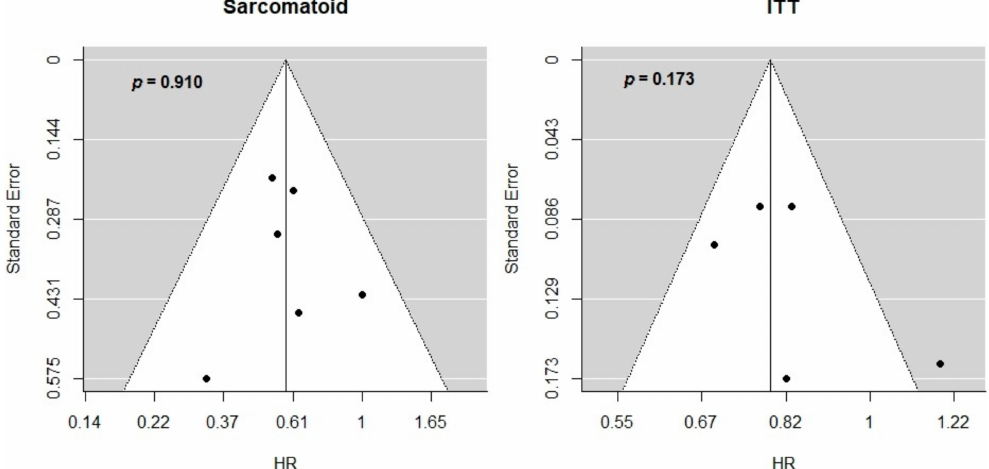
Figure 2. Interactions between HR for progression or death and sarcomatoid histology. Funnel plots of PFS-HR for sarcomatoid sub-group and ITT population. Publication bias was evaluated by visual asymmetry and p -values are obtained by regression tests for funnel plot asymmetry. The y -axis reports standard error while the x -axis reports the e ff ect sizes, that is, HR for PFS in sarcomatoid sub-group (left-hand size) and ITT (right-hand